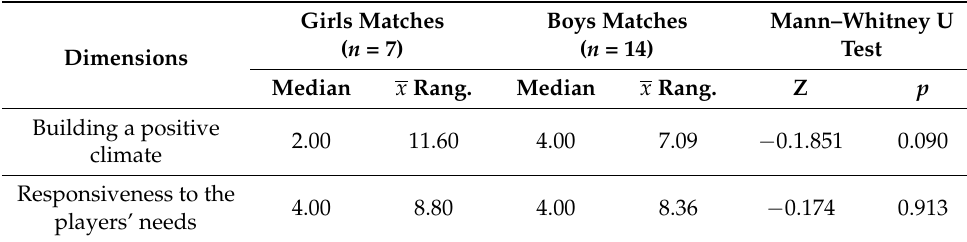
Table 5. Differences in the assessment of the quality of referee–players’ interactions in two dimensions depending on the refereed girls’ or boys’ matches ( n =